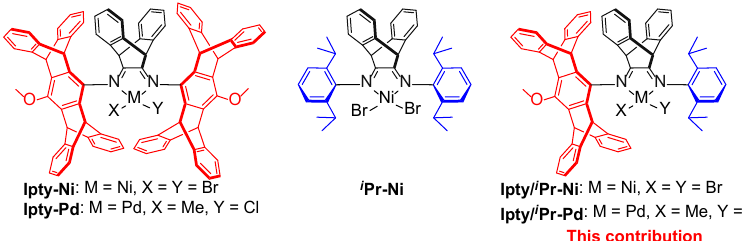
Scheme 2. The unsymmetrical strategy on the α -diimine nickel and palladium catalysts in this